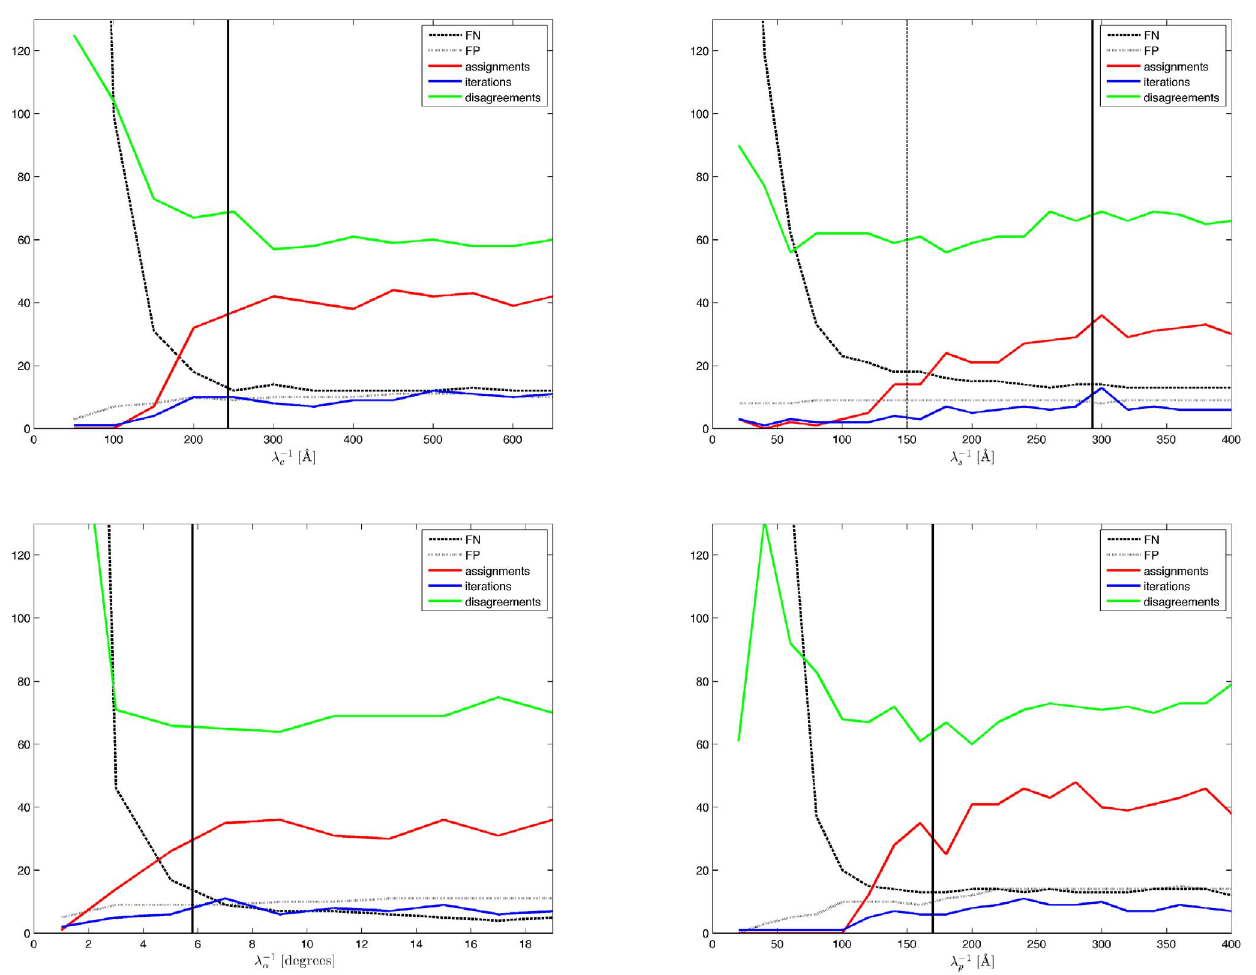
Figure 13. Matching performance over parameter variations. Displayed are false negatives (FN), false positives (FP), number of manual assignments, number of iterations, and number of disagreements when varying matching parameters around their maximum-likelihood estimates (indicated by solid vertical line) for the X. laevis sample: top left: by direct position distance parameter l { 1 indicates the value that we chose instead of the maximum-likelihood estimate); bottom left: by angle difference parameter l { 1 distance parameter l { 1 p